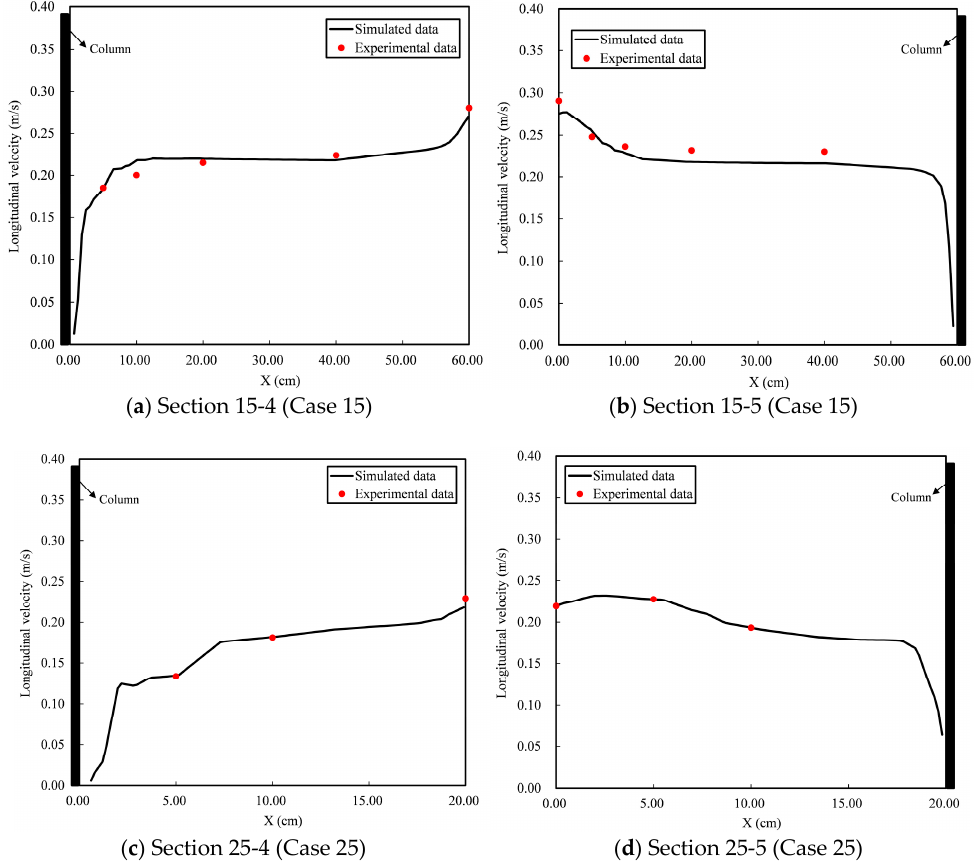
Figure 9. Distribution of the simulated vertical average velocity and the experimental vertical average velocity of the longitudinal section between the front row and back row of vertical columns. (a) Section 15-4 is the longitudinal section behind the second vertical column of sixth row (Y = 10.7 cm) in Case 15; (b) Section 15-5 is the longitudinal section before the second vertical column of the seventh raw (Y = 14.3 cm) in Case 15; (c) Section 25-4 is the longitudinal section behind the second vertical column of seventh row (Y = 7.1 cm) in Case 25; (d) Section 25-5 is the longitudinal section before the second vertical column of seventh row (Y = 10.7 cm) in Case 25.